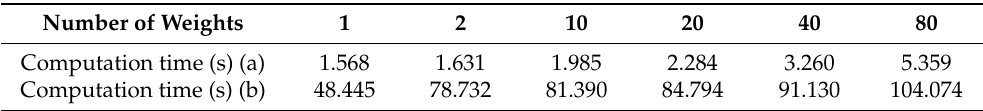
Table 4. Processing result according to number of